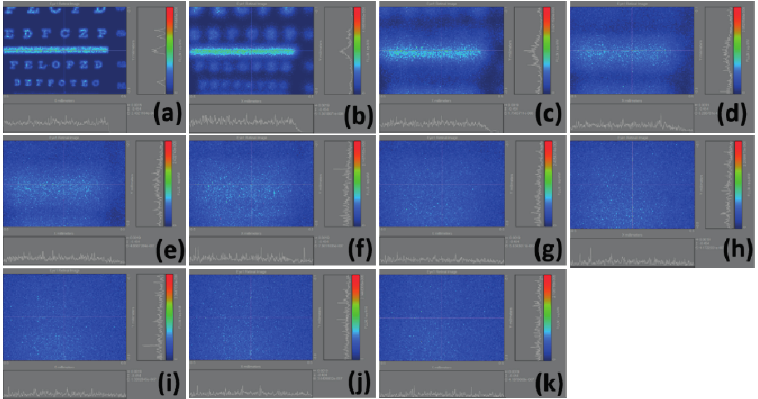
Figure 9. Calculation results of retinal images by selecting the whole Snellen chart in Figure 3(f); ( a ) plano; ( b )1.00 D; ( c ) 2.00 D; ( d ) 3.00 D; ( e ) 4.00 D; ( f ) 5.00 D; ( g ) 6.00 D; ( h ) 7.00 D; ( i ) 8.00 D; ( j ) 9.00 D; ( k ) 10.00